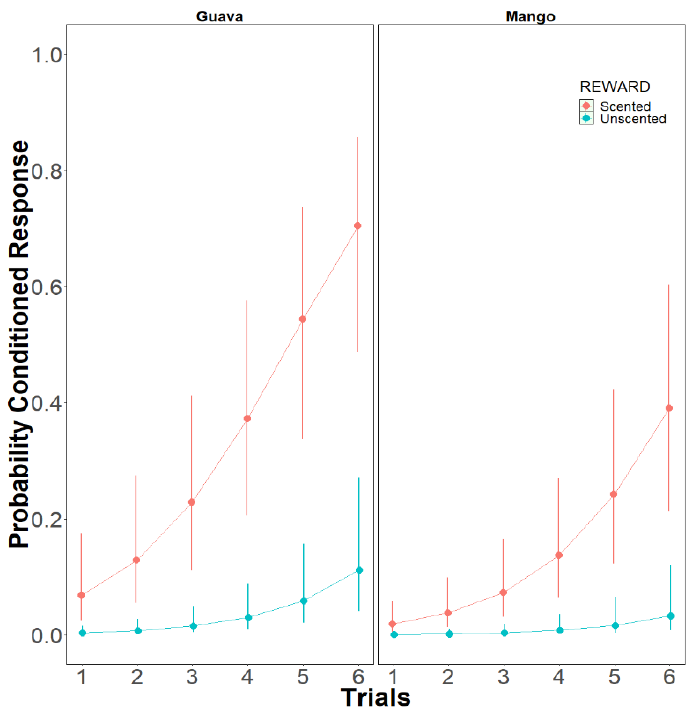
Figure 3. Probability of the conditioned response PER in the stingless bees, Melipona eburnea on day 1. Bees conditioned with scented-US reward increased the conditioned response. The increment